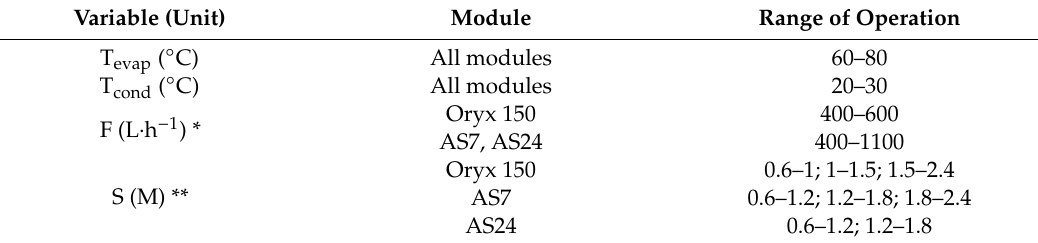
Table 2. Operating conditions tested on the three commercial MD